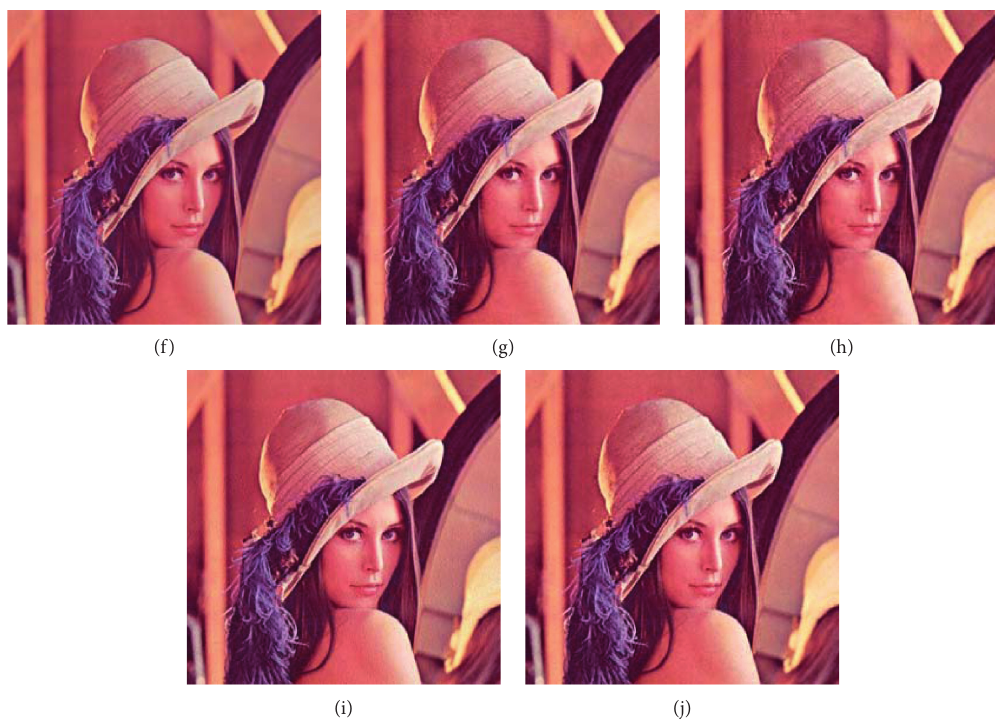
Figure 6: Comparison of difference compressive sensing and reconstruction algorithm at medium sample rate ( R � 0.5). (a) Airplane.